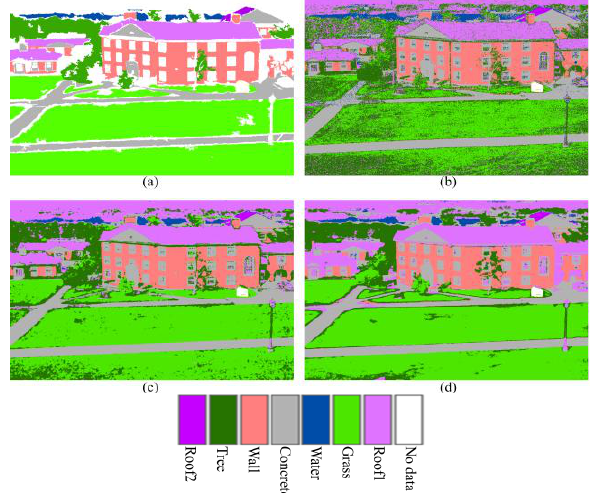
Figure 6: Classification results of Scene 1 images including (a) ground truth data generated manually and the classification results of (b) HRC image, (c) Vpan-RGB fused image, and (d) Pan-NRGB fused image.